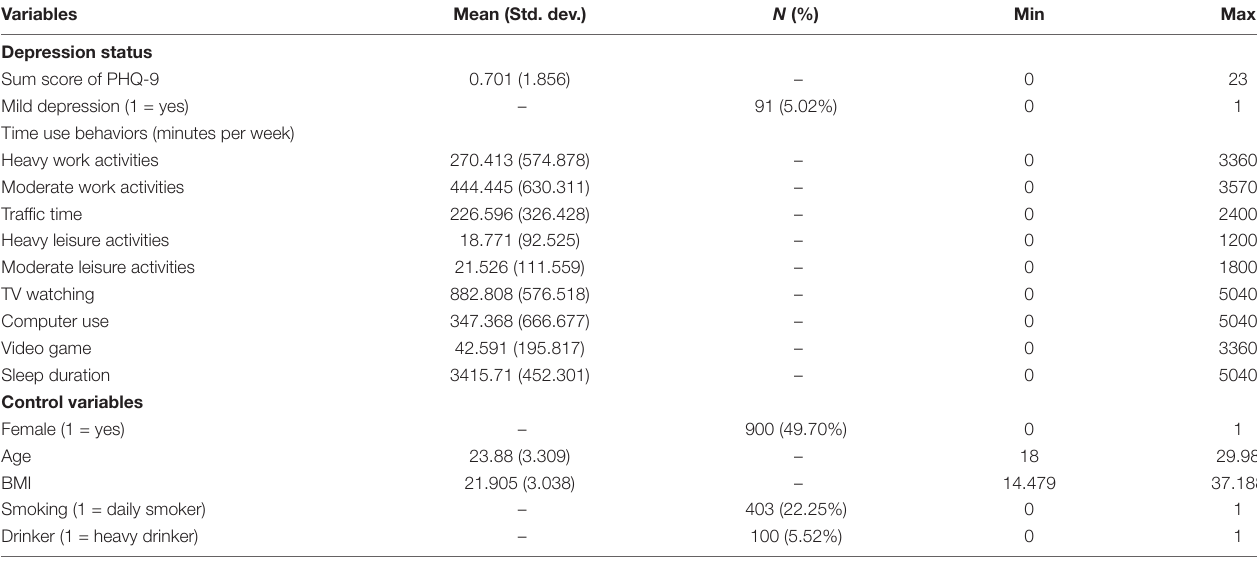
TABLE 1 | Descriptive statistics ( N = 1,811).